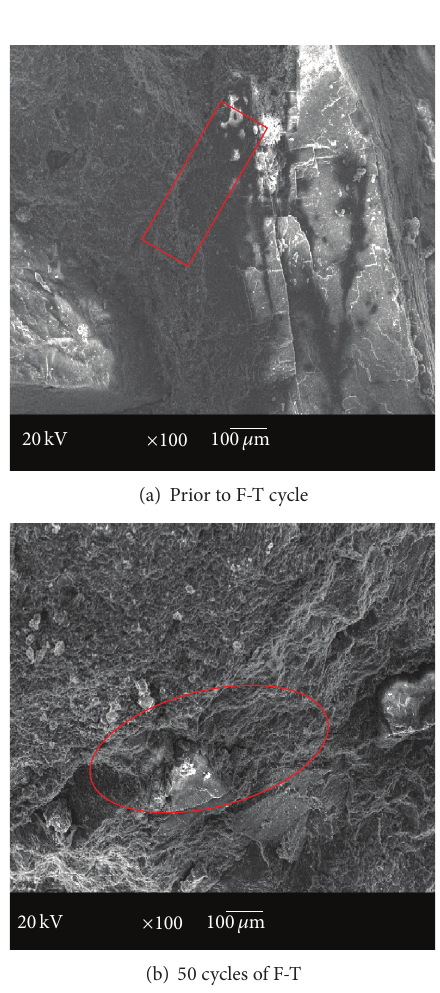
Figure 1: Scanning electron SEM microphoto graphs of plain concrete after F-T cycles.